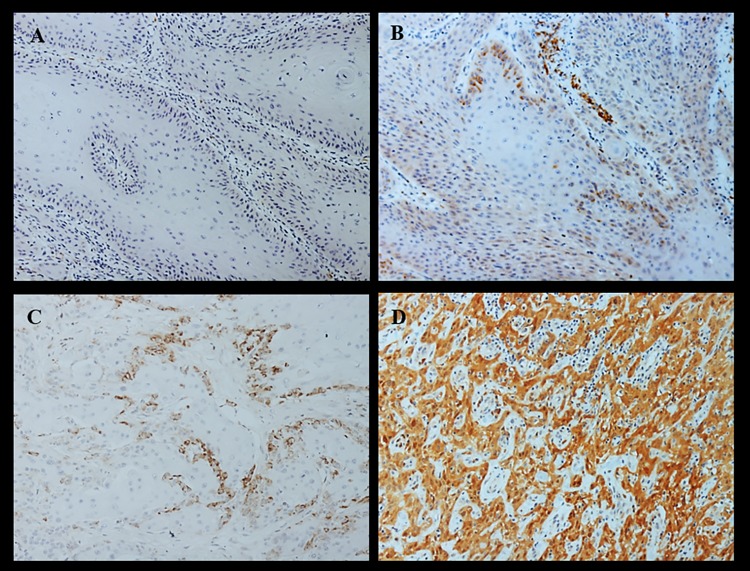
Patterns of p16 expression in penile carcinomas.(A) Pattern 0: complete absence of staining in all neoplastic cells. (B) Pattern 1: irregular and discontinuous individual staining in some of the neoplastic cells. (C) Pattern 2: a more extensive, although discontinuous, staining pattern with small clusters of positive neoplastic cells. (D) Pattern 3: continuous and complete cytoplasmic and nuclear staining in all neoplastic cells. Only pattern 3 was considered positive for p16.